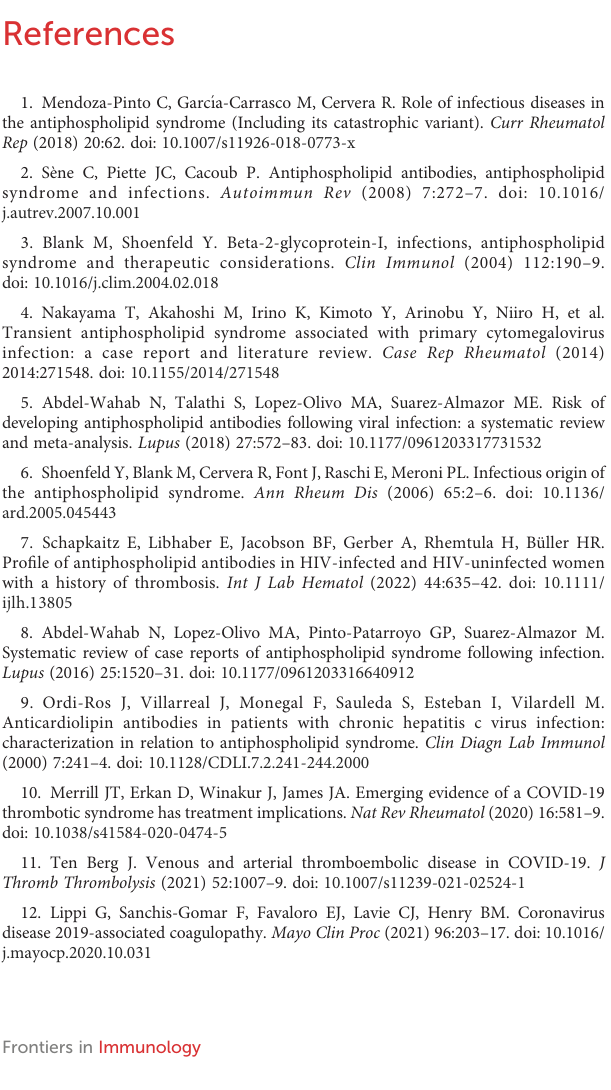
SUPPLEMENTARY FIGURE 1. Ig fractions from patients with AIS during COVID-19 induce ERK and p38 phosphorylation. Human platelets from healthy donors were treated for 10 min with Ig fractions (200 mg/ml) from 10 AIS/COVID-19 patients. Protein extracts were separated by SDS-PAGE and analyzed by western blot to investigate: (A) phosphorylated and total ERK, using anti-phospho-ERK1/2 and anti-total- ERK1/2 antibodies. (B) phosphorylated and total p38 MAPK using anti-phospho-p38 and anti- total-p38